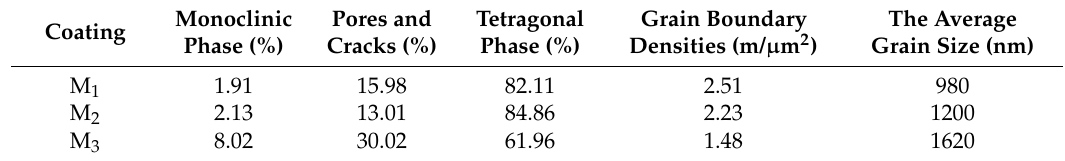
Table 3. Microstructures